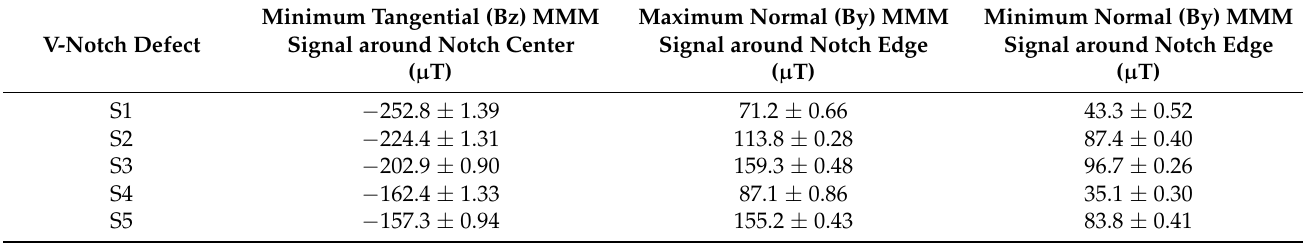
Table 2. Maximum and minimum values of tangential and normal MMM signals around the center and edges of the five V-shaped notches of an ASTM-A36 steel pipe.